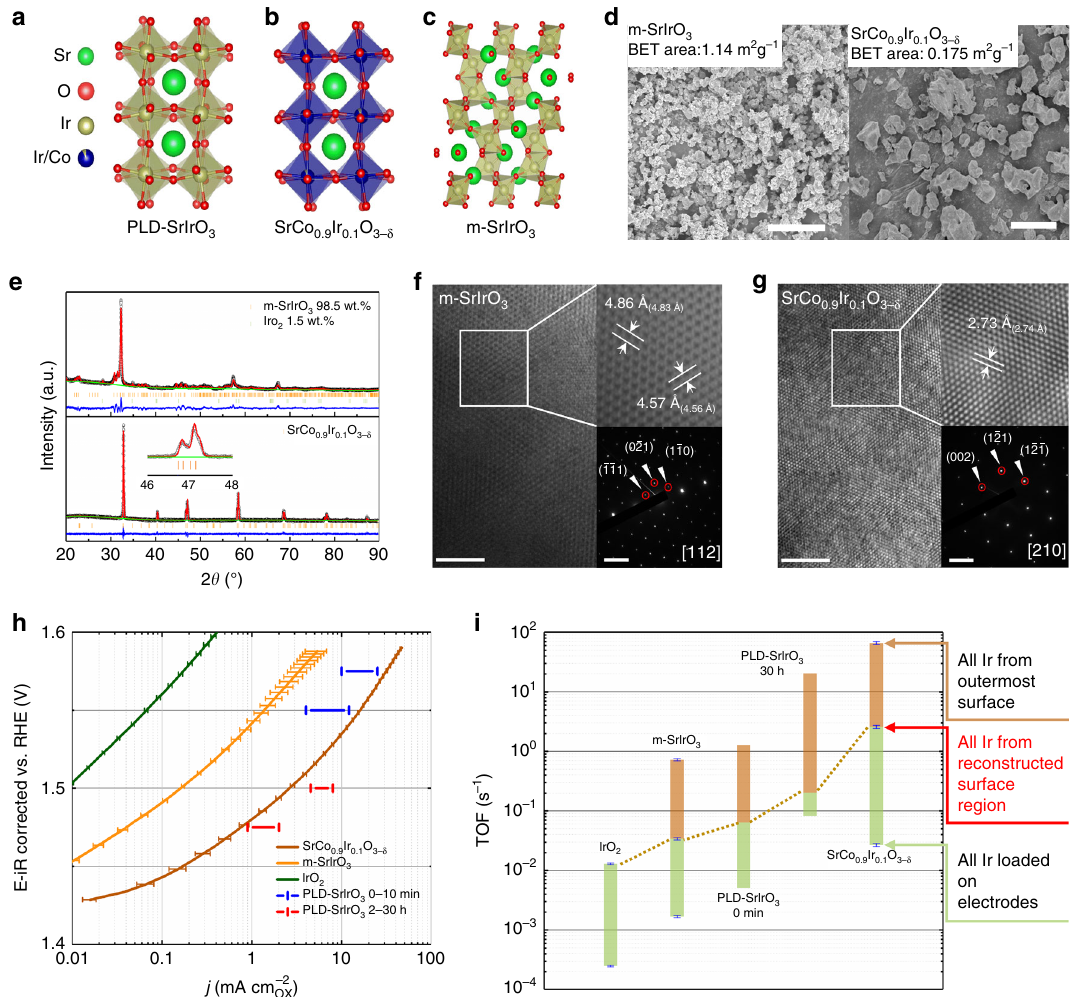
Fig. 1 Crystal structure and OER activity of SrCo 0.9 Ir 0.1 O 3 − δ . Crystal structures of a PLD-SrIrO 3 17 , b pseudo-cubic SrCo 0.9 Ir 0.1 O 3 − δ , and c m-SrIrO 3 . d scanning electron microscopy (SEM) images of as-prepared m-SrIrO 3 (scale bar, 5 µ m) and SrCo 0.9 Ir 0.1 O 3 − δ (scale bar, 20 µ m) . e Rietveld re fi nement of